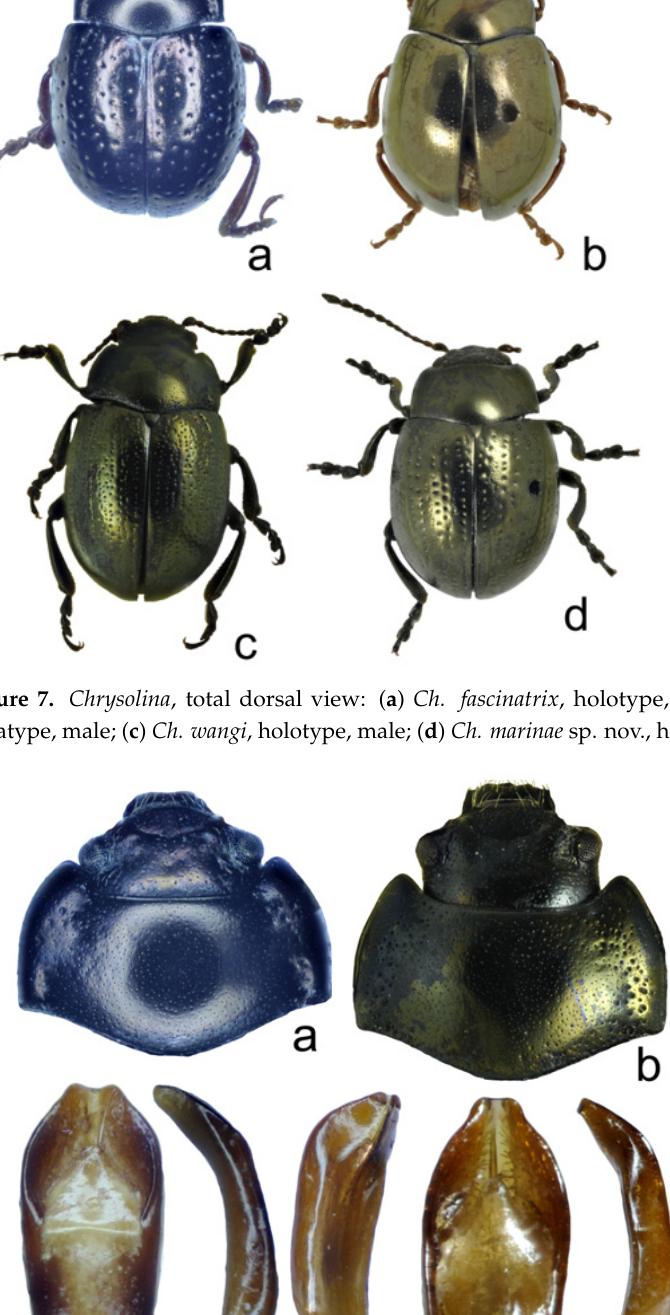
Figure 9. Distribution of the species of the subgenus Chrysolina ( Volosatik ): (green) Ch. igori sp. nov.; (red) Ch. fascinatrix ; (light blue) Ch. liqingzhaoae ; (purple) Ch. marinae sp. nov.; (yellow) Ch. genriki sp. nov.; (black) Ch. wangi ; (dark blue) Ch. ilyakabaki sp. nov. Chrysolina fascinatrix Lopatin, 1998: 831. Type locality. China, NW Yunnan, 20 km E Weixi.